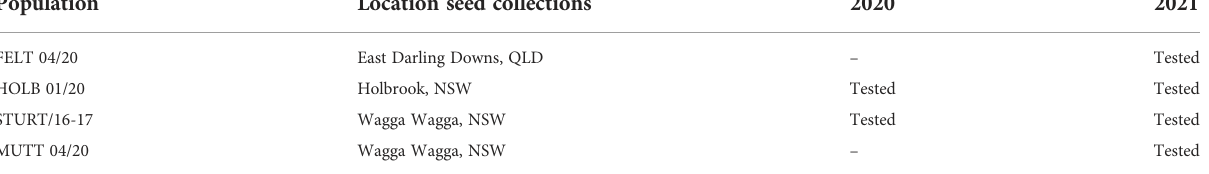
TABLE 1 Feathertop Rhodes grass populations were tested against four different seed-damaging treatments (untreated control, silage, digestion, silage plus digestion) in 2020 and 2021.